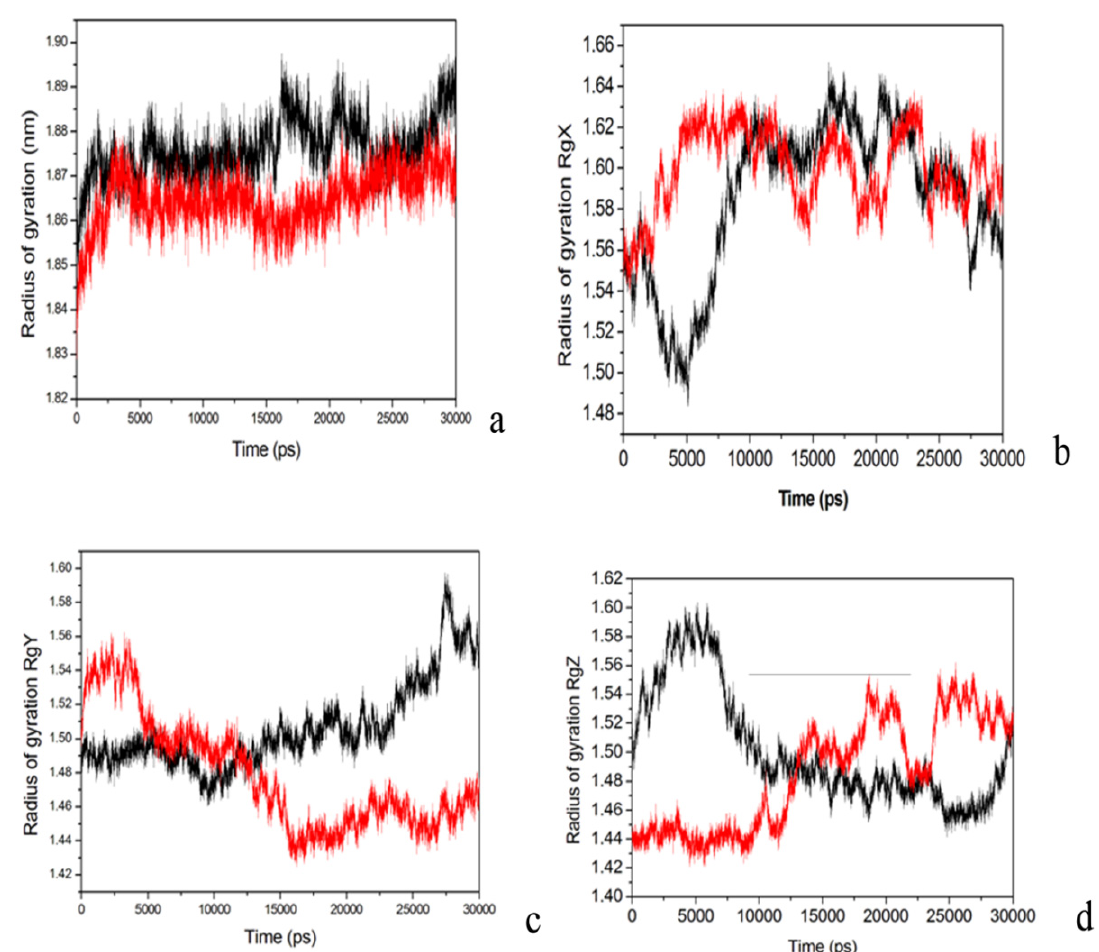
WT PTE (red), loop 7-2/H254R (black); ( c ) Rg x WT PTE (red), loop 7-2/H254R z